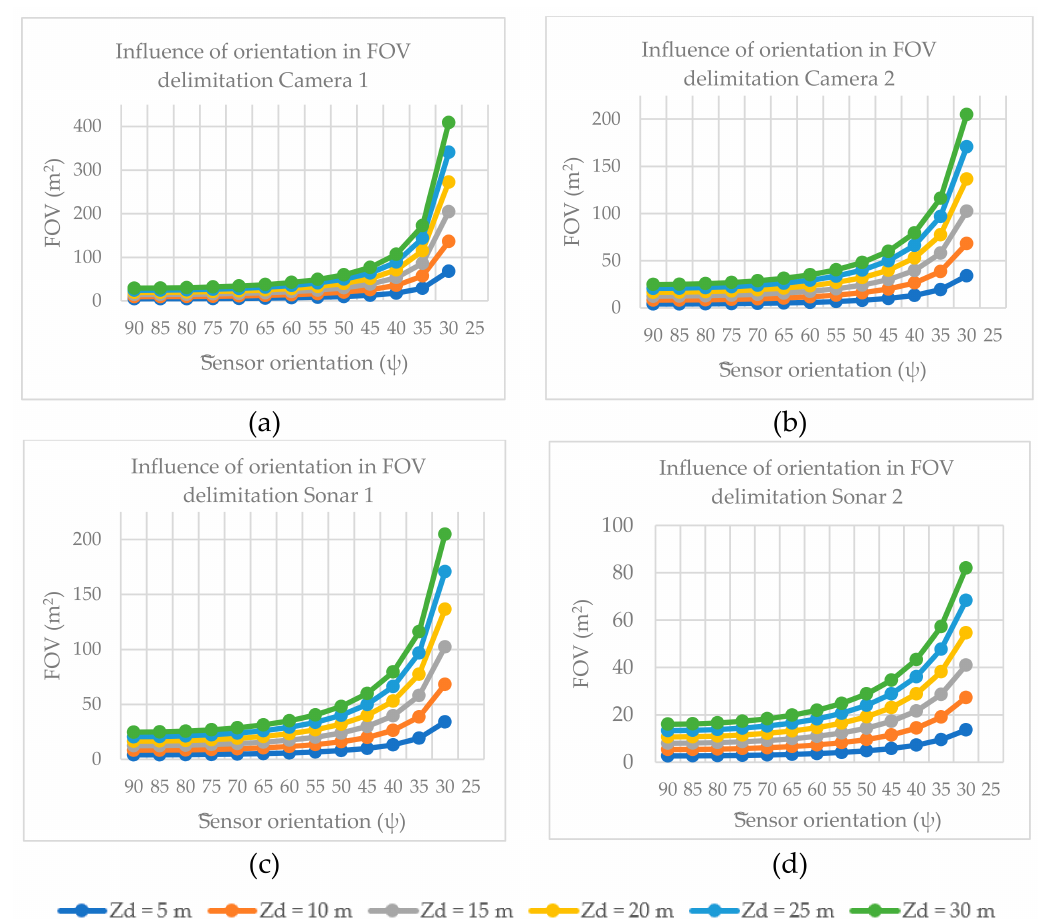
Figure 7. FOV variations for different depths and inclinations. Influence of orientation in FOV delimitation ( a ) Camera 1, ( b ) Camera 2, ( c ) Sonar 1 and ( d ) Sonar